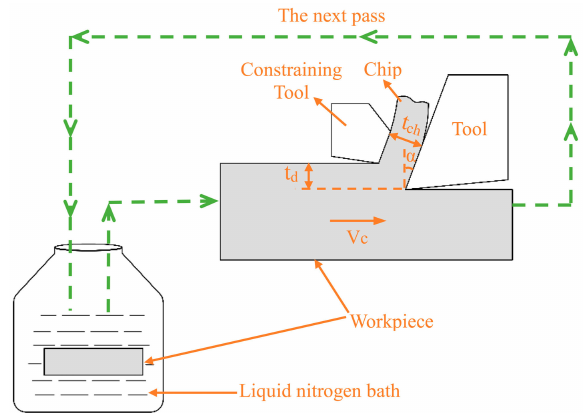
Figure 1. Schematic view of CT-LSEM, the workpiece should be immersed into the liquid nitrogen